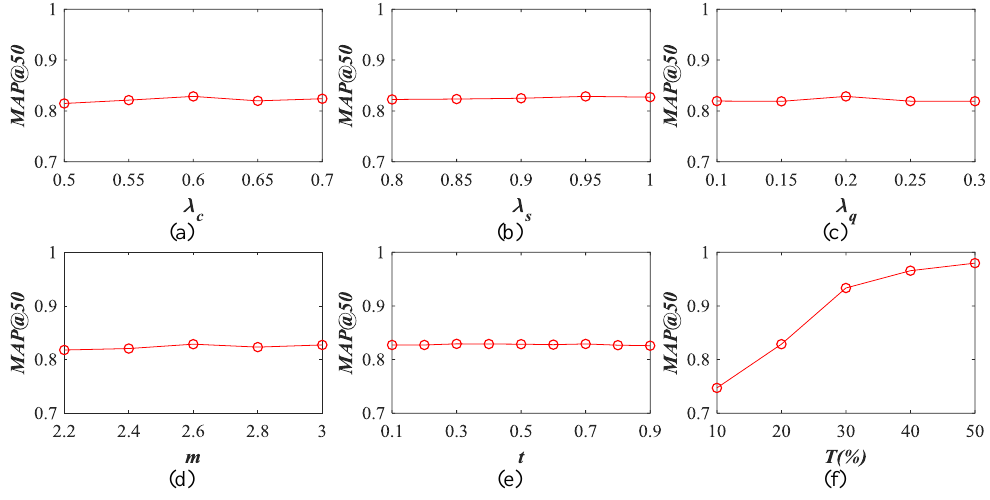
Figure 20. Influence of different parameters on our hash learning model. The results are counted on the UCM dataset using the 128 bits hash codes: ( a ) λ c ; ( b ) λ s ; ( c ) λ q ; ( d ) m ; ( e ) t ; and ( f ) T